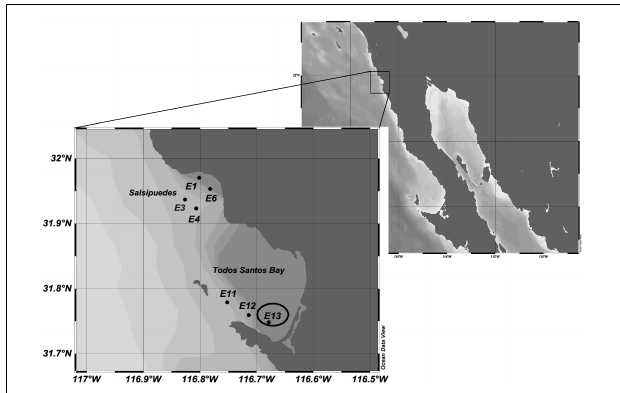
FIGURE 1 | Sampling stations located in Todos Santos Bay (TSB) region. Station 13 enclosed in the circle is inside the mussel cultivation